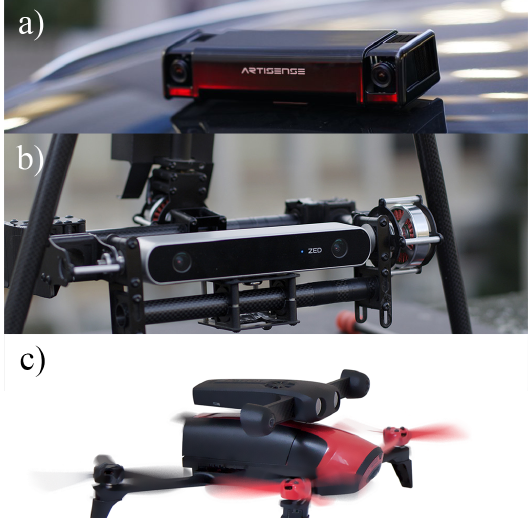
Figure 1: Stereo vision sensors: a) ARTISENSE VINS (Ar- tisense Corporation, 2019), b) ZED stereo camera (StereoLabs, 2019) and c) Parrot S.L.A.M.dunk (Parrot Drones SAS, 2019)